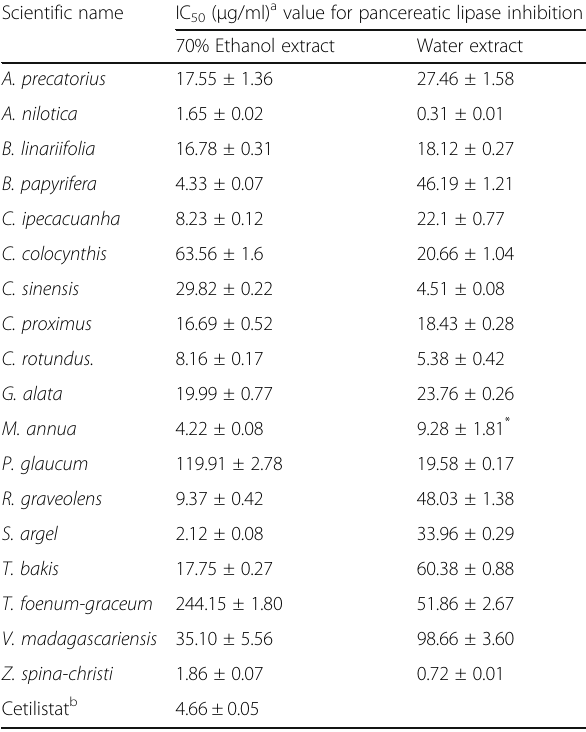
Table 5 Pancreatic lipase inhibitory activity of